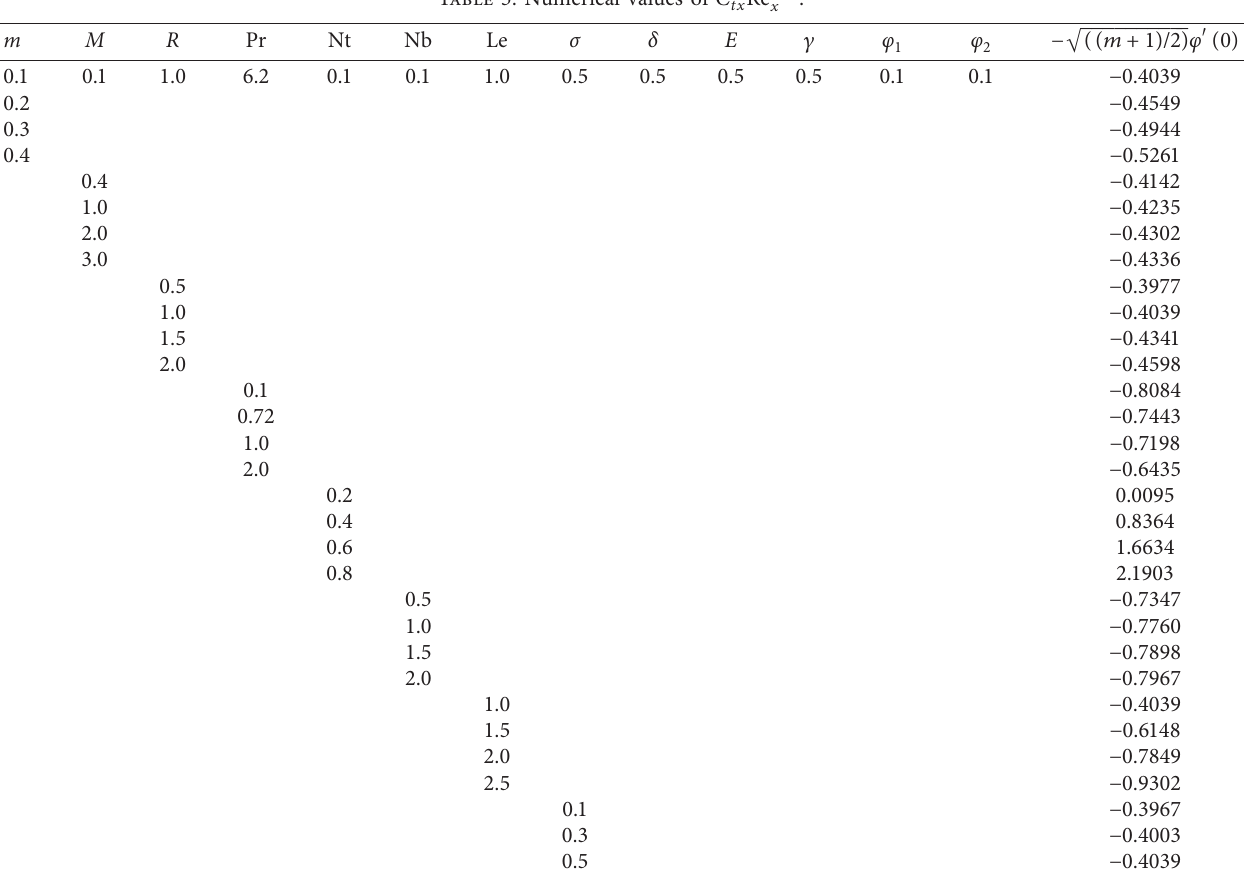
Table 5: Numerical values of 􏽥 C